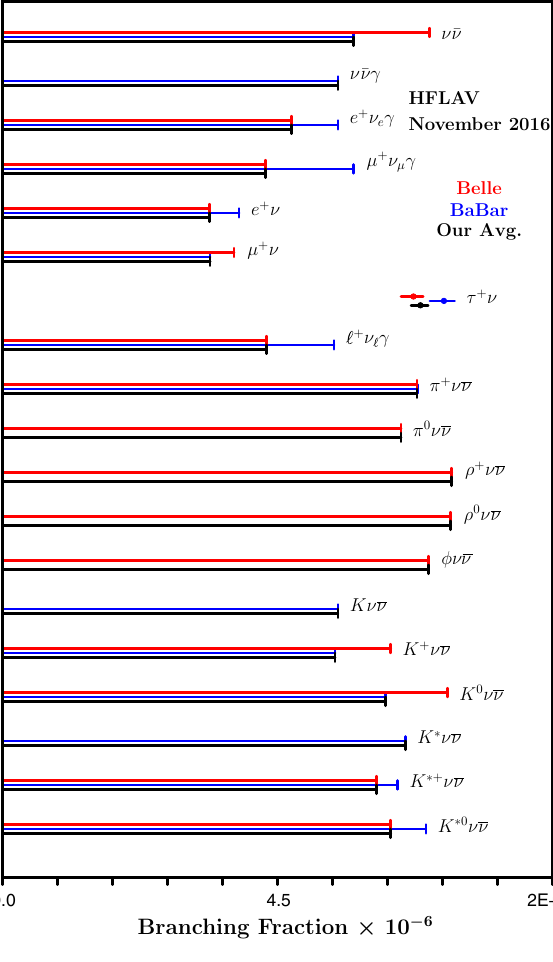
Fig. 187 Branching fractions of charmless B decays with